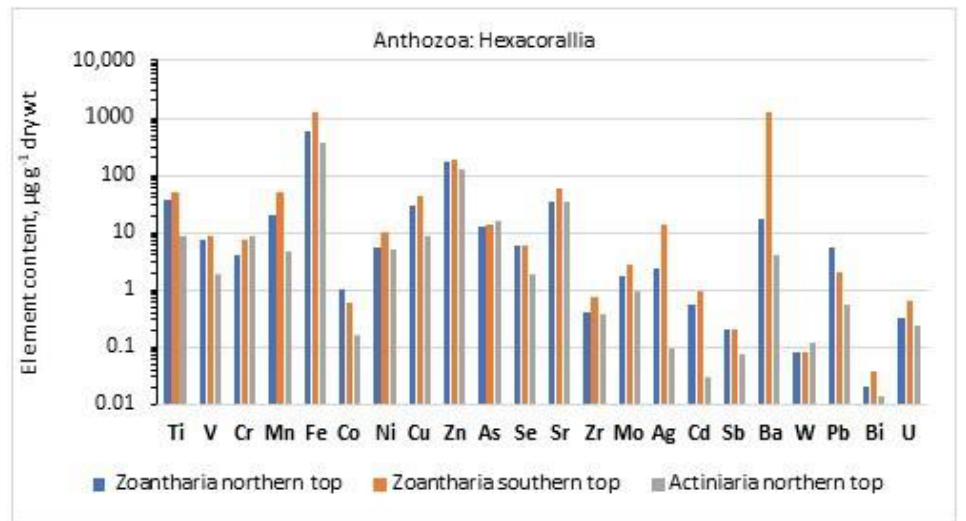
By the analogy with Zoantharia and Actiniaria, a rather high concentration of Sr (556 µg g − 1 dry wt. on average), which are comparable with those for Fe and Zn, were deter- mined in the soft coral Alcyoniidae Heteropolypus ritteri that inhabited the southern top.